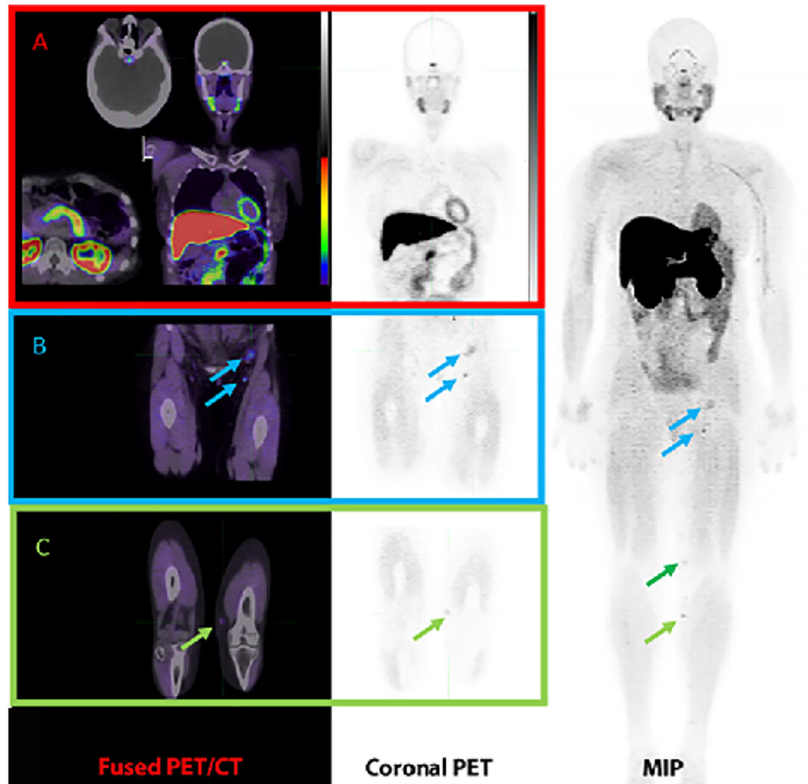
Fig. 5 Imaging activated CD8 T cells with 18 F-AraG. Baseline imaging a patient with recurrent malignant melanoma, scanned at 60 min after IV injection of approximately 185 MBq of 18 F-AraG prior to immune check-point therapy. A Maximum intensity projection (MIP) image demonstrates uptake in inguinal nodal disease (Blue arrows) and in transit nodules (Green arrows). Panel ( A ): Fused PET/CT and coronal PET images demonstrate moderately intense uptake in the pituitary, salivary glands, myocardium, liver and pancreas. All these organs are subject to immune-related adverse events and how this biodistribution will impact diagnostic performance is unclear. Panel ( B ): Increased uptake is observed in two inguinal lymph nodes, with associated nodal enlargement of the upper node. Panel ( C ): The small lower in transit nodule is clearly identi fi ed on both PET and correlative CT (Image provided by Dr Diwakar Davar and Dr Shyam Srinivas from University of Pennsylvania Medical Center and Dr Jelena Levi of